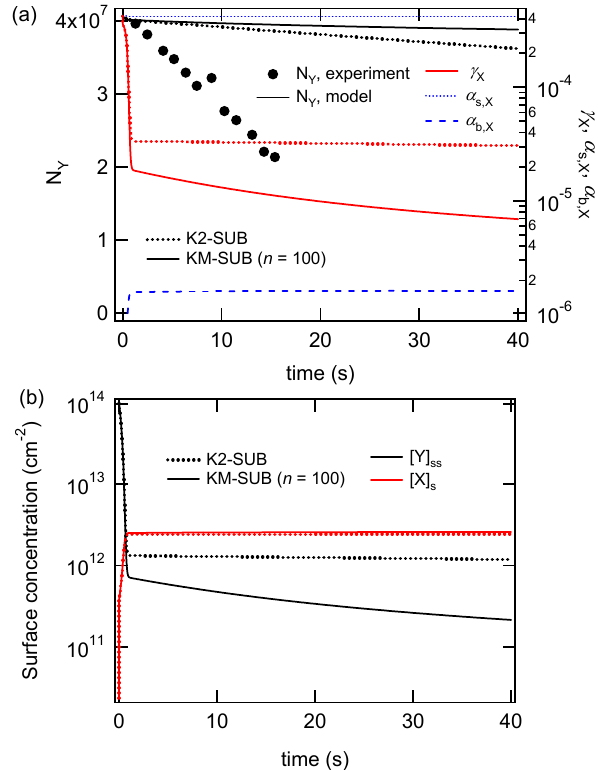
Fig. 8. Temporal evolution of model base case 3 with KM-SUB ( n = 100). (a) Experimental data (black symbols; Ziemann, 2005) and model results for the total number of oleic acid molecules ( N Y , black line) and for the uptake coefficient of ozone ( γ X , red line), sur- face accommodation coefficient ( α s , X , blue dotted line), and bulk accommodation coefficient ( α b , X , blue dashed line). (b) Surface concentrations of oleic acid (black line) and ozone (red line).